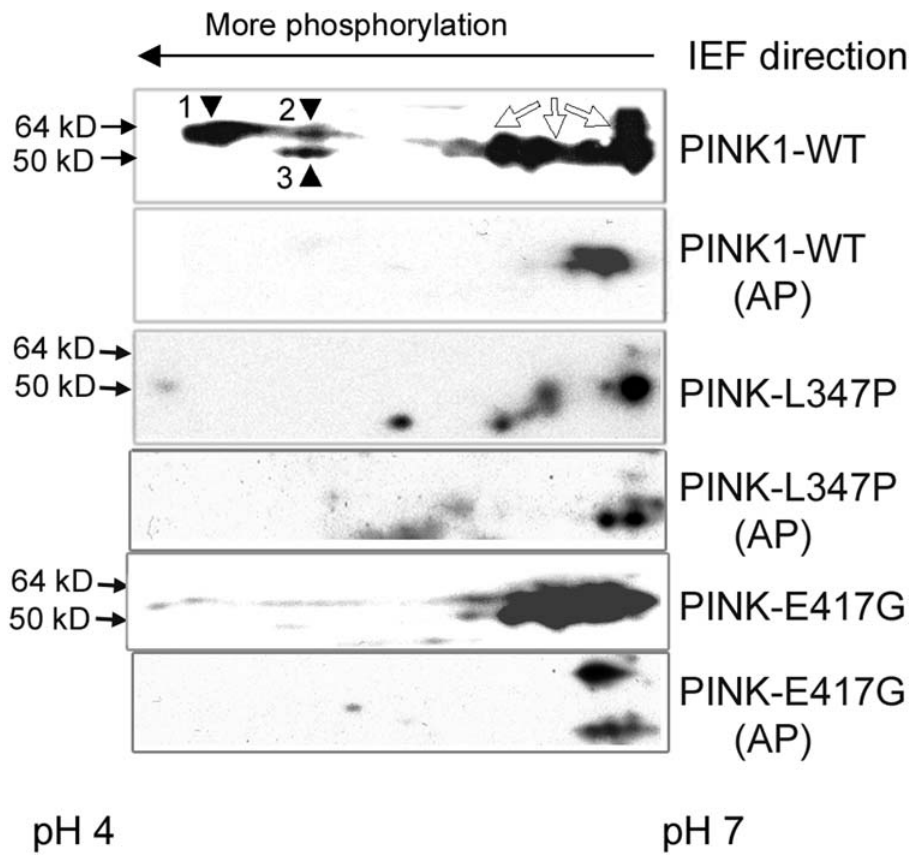
Figure 2. PINK1 auto-phosphorylation is impaired by L347P and E417G mutations. PINK1 protein is auto-phosphorylated in the cells expressing wild type PINK1 and the auto-phosphorylation was decreased in cells expressing L347P- or E417G-PINK1. Lysates from the SH-SY5Y cells expressing wild type-PINK1-Flag (1 st and 2 nd panels), L347P-PINK1-Flag (3 rd and 4 th panels) or E417G- PINK1-Flag (5 th and 6 th panels) were subjected to 2-dimensional gel electrophoresis, followed by Western analyses using anti-Flag Ab. Of the same protein, the more phosphorylated ones migrated to the more acidic end (left hand) of the isoelectric focusing (IEF) gel, while less or non-phosphorylated ones migrated to the more basic end (right hand) of IEF. 1 st panel: Wild type PINK1 along the pH gradient of the IEF. Spot 1, 2 (64 kD), and 3 (50 kD) migrated to the acidic end, and several others (open arrows) to the basic end. 2 nd panel: A control of wild type PINK1 proteins treated with alkaline phosphotase (AP). While the spots on the basic end still remained in the same region of the gel as in the 1 st panel, spot 1, 2, and 3 were missing. This indicated that these 3 spots were phospho-PINK1 in 1 st panel, and were de-phosphorylated in the 2 nd panel. The difference between spot 1 and 2 reflected the degree of phosphorylation on PINK1. In cells expressing L347P or E417G-PINK1, spot 1, 2 and 3 were greatly reduced, indicating reduced auto-phosphorylation on L347P- or E417G-PINK1 (3 rd and 5 th panels). The 4 th and 6 th panels are controls (treated with AP) for the 3 rd and 5 th panels respectively, similar to the 2 nd